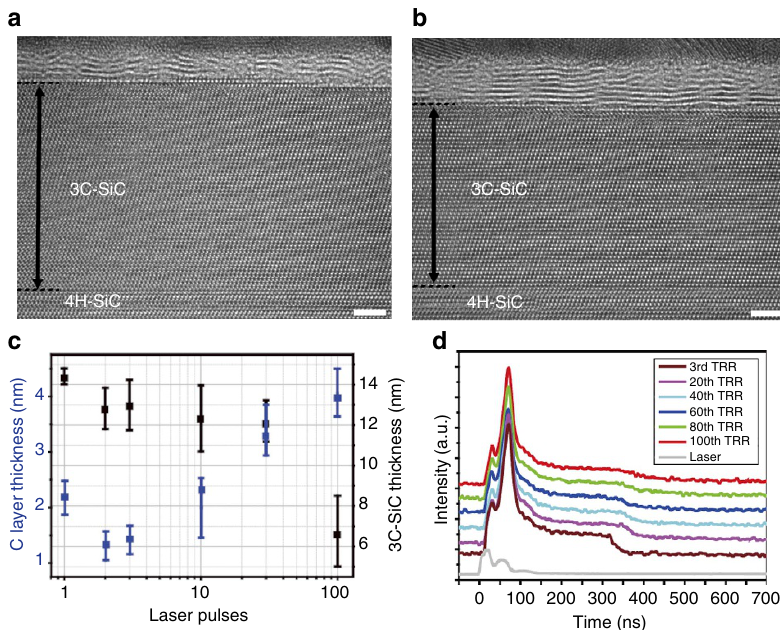
Figure 5 | Increase in the number of C layers by multi-pulse irradiation. ( a , b ) HRTEM images of 4H-SiC surfaces after a 3 ( a , left) and 10 ( b , right) irradiation pulses. Double-sided arrows indicate 3C-SiC layers. Scale bars, 2nm. ( c ) Systematic investigation of thickness variations of the C and 3C-SiC layers as a function of the number of laser pulses from 1 to 100. Square labels represent the average values of thickness from each pulse. Error bars indicate minimum and maximum values of thickness at each pulse. ( d ) TRR signals of 4H-SiC surfaces with multi-pulse irradiations, from the third to the hundredth (Supplementary Fig. 10d,e). In contrast, laser fluence E2 caused graphitization from the amorphous SiC layer ( B 17nm) through sublimation of Si element (Supplementary Fig. 10f), C nucleation (Supplementary Fig. 10g), formation of multilayer graphene (Supplementary Fig. 10h), in sequence, by increasing the number of laser pulses up to several hundreds of irradiations. On the other hand, thin phase-separated C and Si layers were observed by using high laser fluence of E3 (Supplementary Fig. 10c).